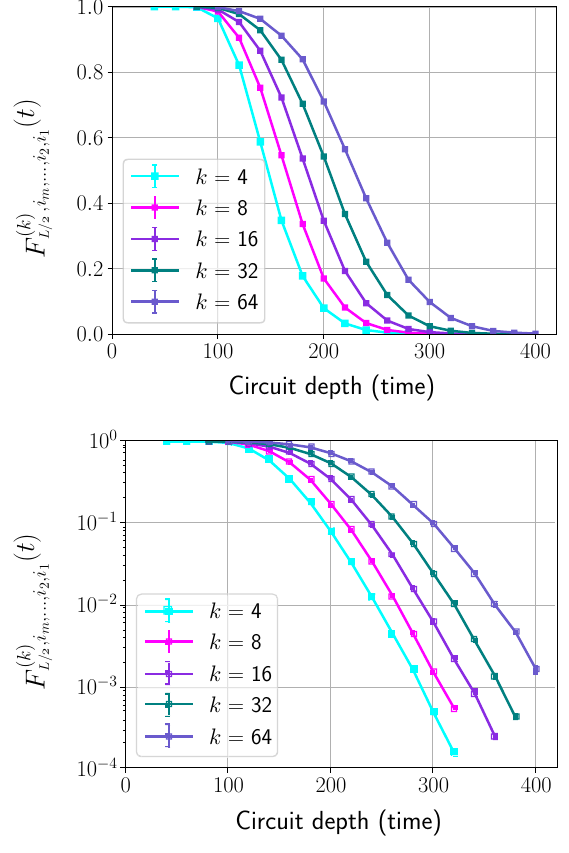
(cid:2) , FIG. 6. The recursive k th-order OTOCs, (cid:5) F ( k ) L / 2, i m , ... , i 2 , i 1 defined in Eq. (34), for a system with L = 100 sites with periodic boundary conditions. These OTOCs are com- posed of single-site Pauli- X operators acting on sites { L / 2, ( k / 2 ) , . . . , 2, 1, 0 } . See Eq. (35) for i m , . . . , i 3 , i 2 , i 1 } = { L / 2, log 2 the forms of the k = 4 and k = 8 operators. We can measure these correlators for very high values of k . Top: the higher-order OTOCs decay at progressively later times. The highest-order OTOCs remain nonzero well past the scrambling time. Bottom: at late times, all correlators eventually decay at an exponential